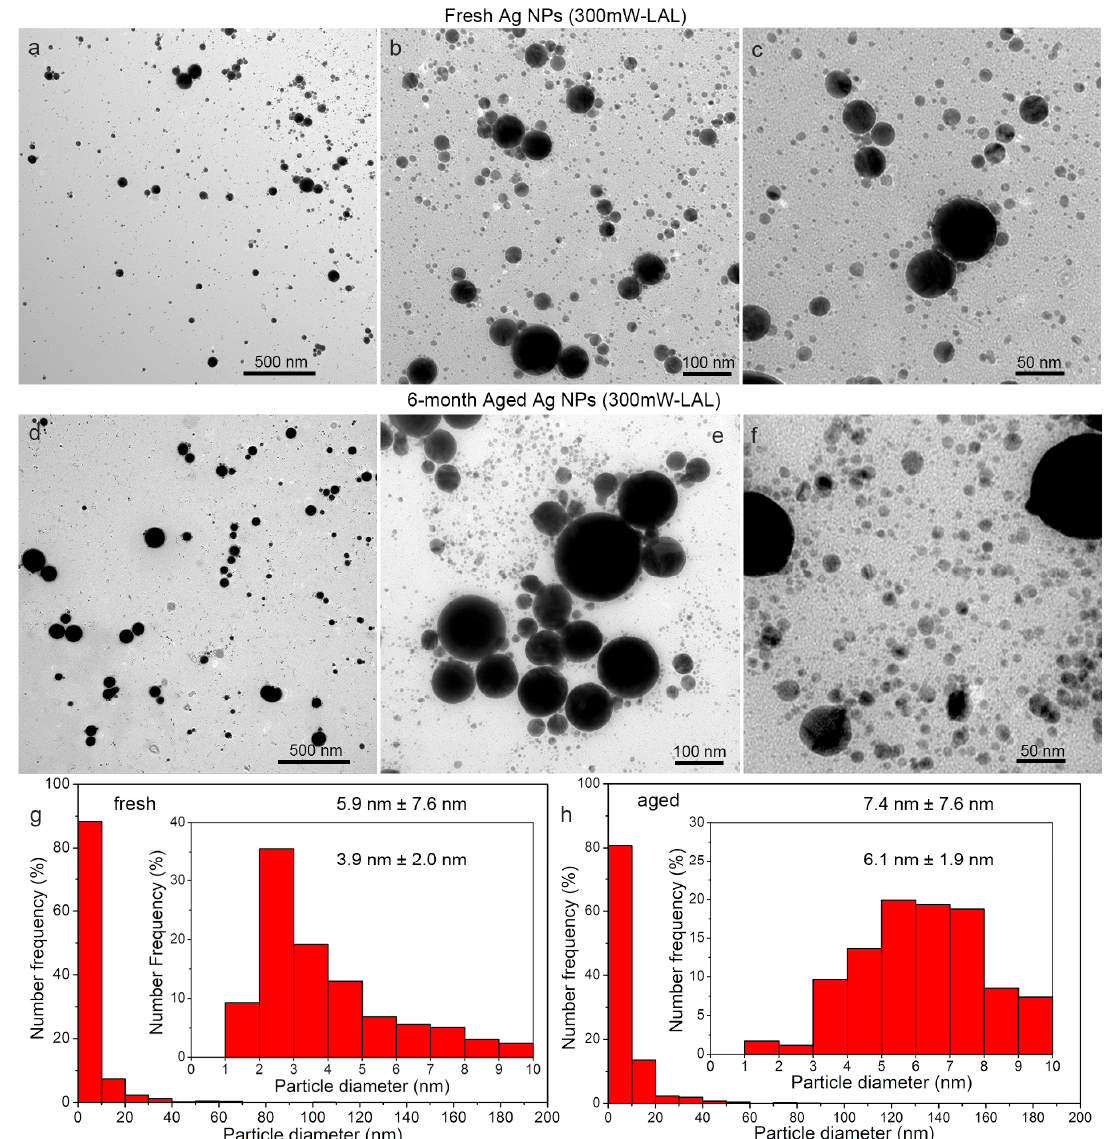
Figure 2. TEM images ( a – f ) and size distributions ( g , h ) of fresh ( a – c , g ) and six month ( d – f , h ) aged Ag particles, synthesized by laser ablation of Ag in acetone, at a laser power of 300 mW.